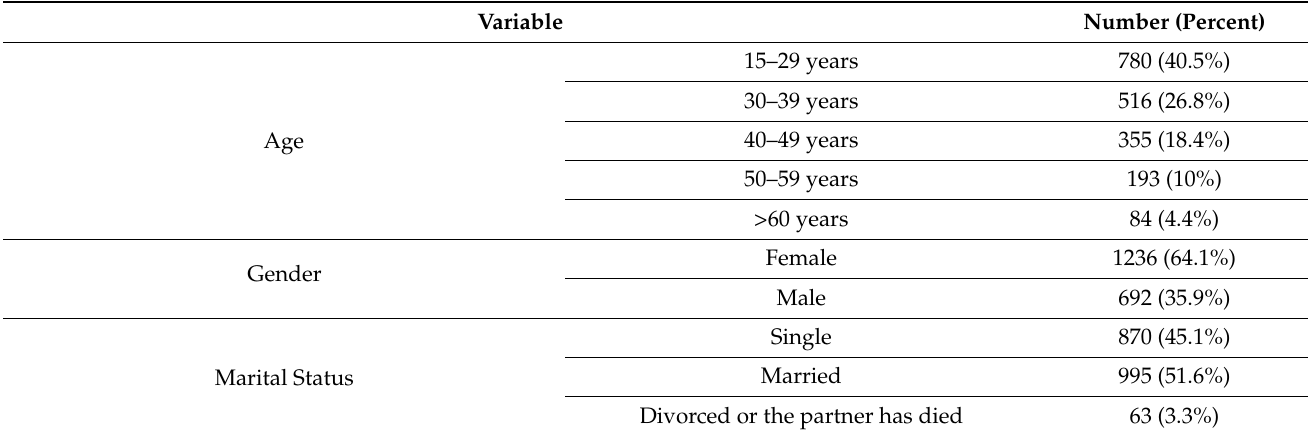
Table 1. Demographic characteristics of participants and their history of COVID-19